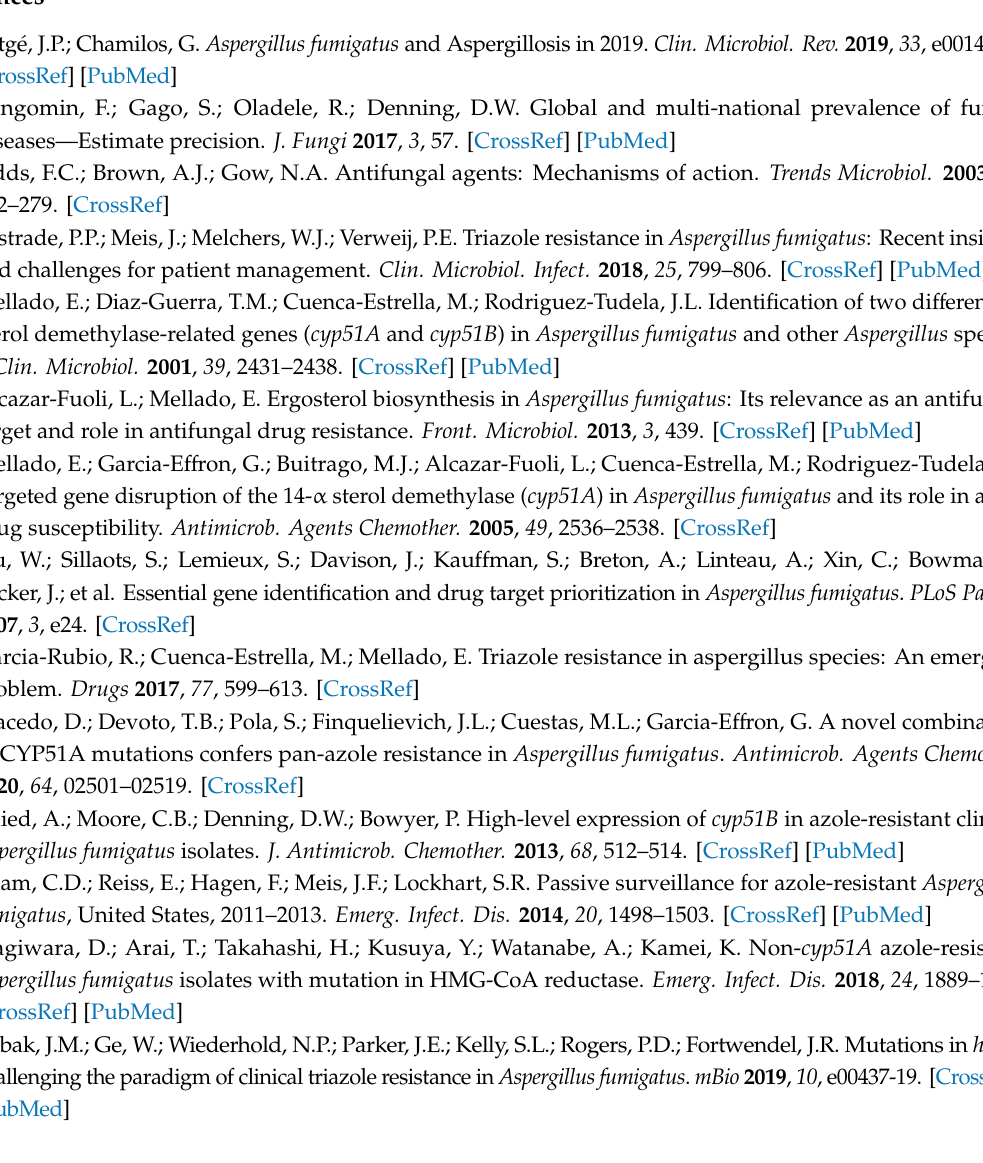
Table S1: Primers used for amplifying, sequencing and qPCR of cyp51A , cyp51B , their promoters and hmg1